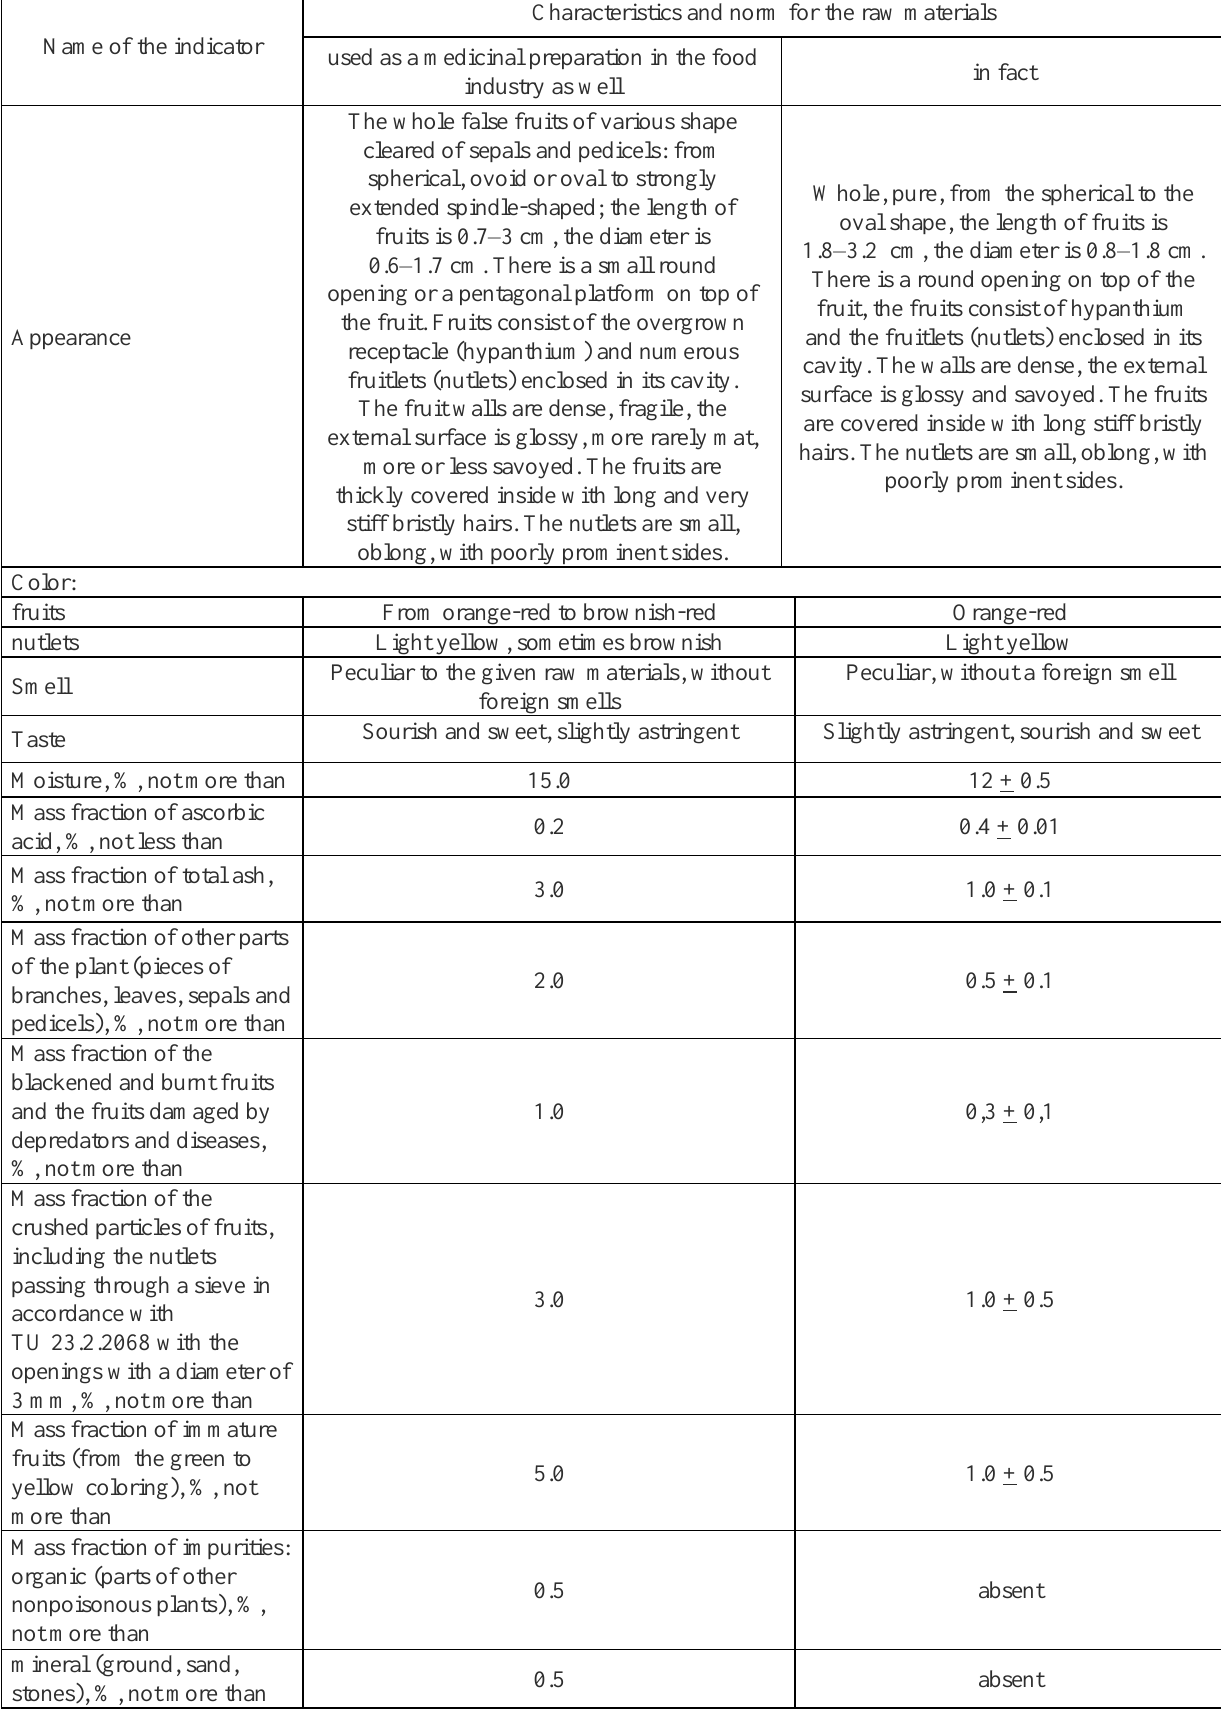
Table 8. Indicators of quality of fruits of Rosa majalis Herrm (cinnamon rose), n =